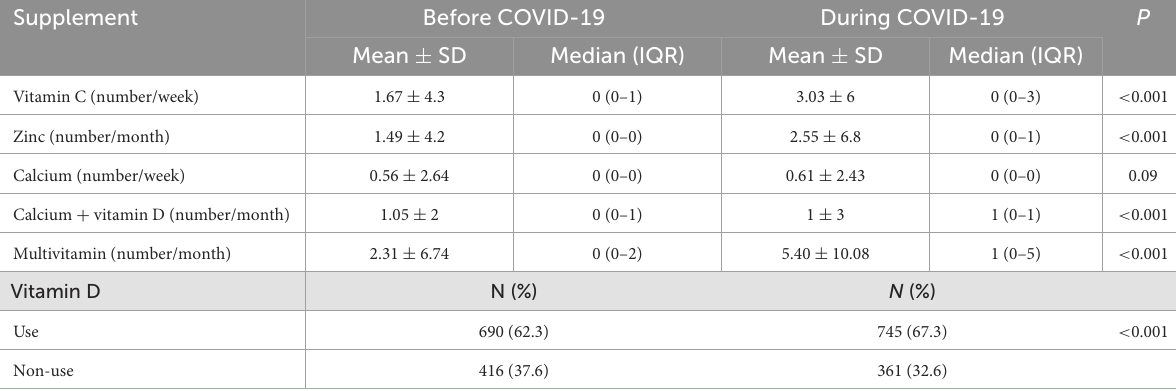
TABLE 4 Dietary supplement intake before and during COVID-19